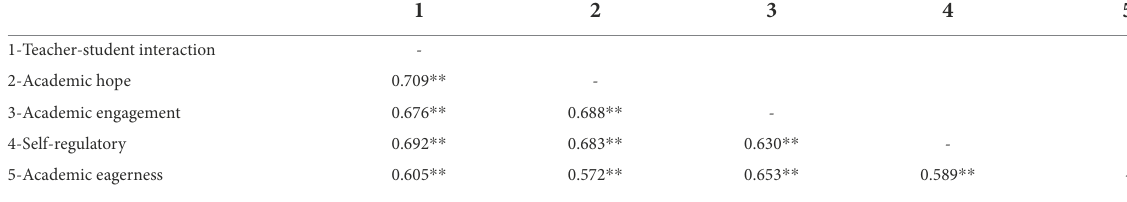
TABLE 4 Correlation between research variables.